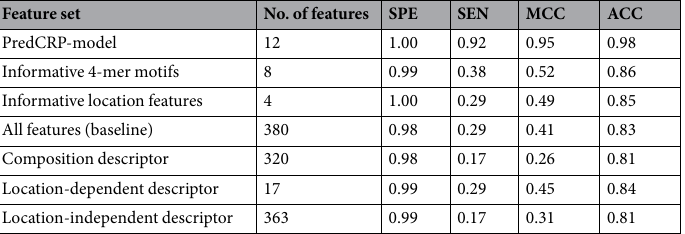
Table 1. Prediction performance comparisons between PredCRP-model and the SVM-based methods with various feature sets on the CRPS-TRN dataset.